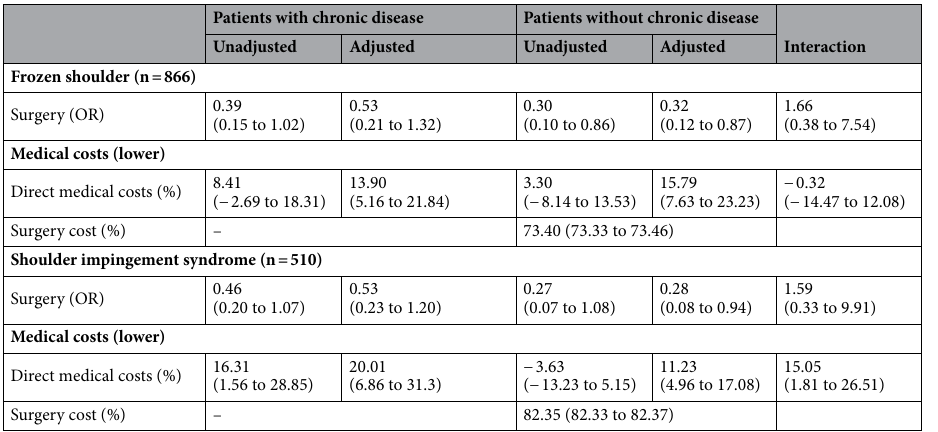
Table 4. Subgroup analysis with comorbidity in shoulder disease. The reference group is low COC group (COC < 0.50 [median]). Effects of COC on surgery cost was estimated using a two-part model. Adjusted covariates are age in category, Gender, Coverage type, frozen shoulder, shoulder impingement syndrome, Charlson comorbidity index, primary provider type, and the total number of medical visits. The interaction between comorbidities and COC was presented. Dashed means reduction in surgery costs was not estimated, because the effect of COC on surgery was not